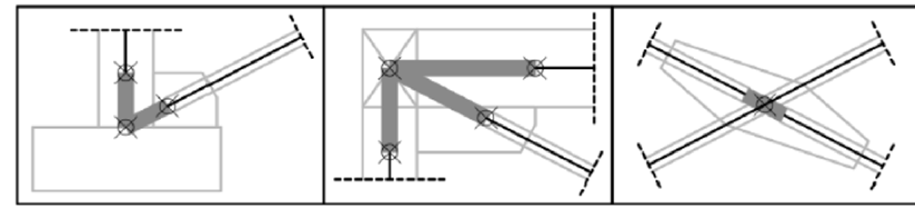
Figure 10. Definition of the rigid parts on the nodal zones. As can be seen in Figure 11, the cyclic numerical response (red continuous line) results very close to the experimental one (black continuous line); thus, the model is considered